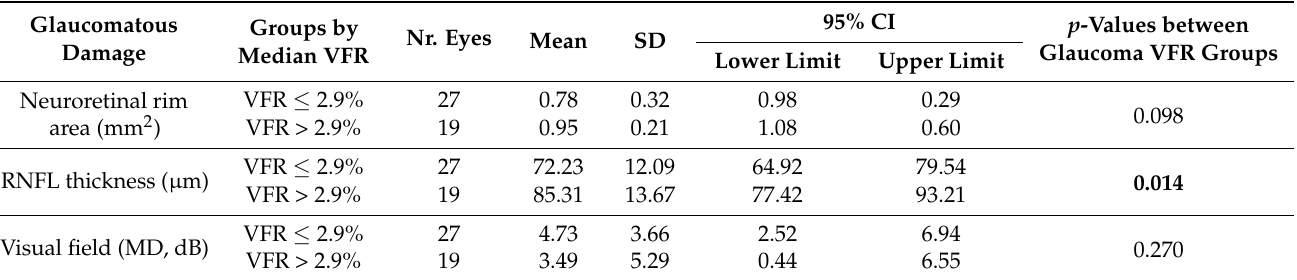
Table 4. Structural and functional glaucomatous damage subdivided in groups by median venular flicker vascular responsiveness: VFR group with ≤ 2.9% VFR dilatation from the baseline diameter and VFR group with >2.9% VFR dilatation from the baseline diameter. p -values < 0.05 are considered statistically significant and are given in